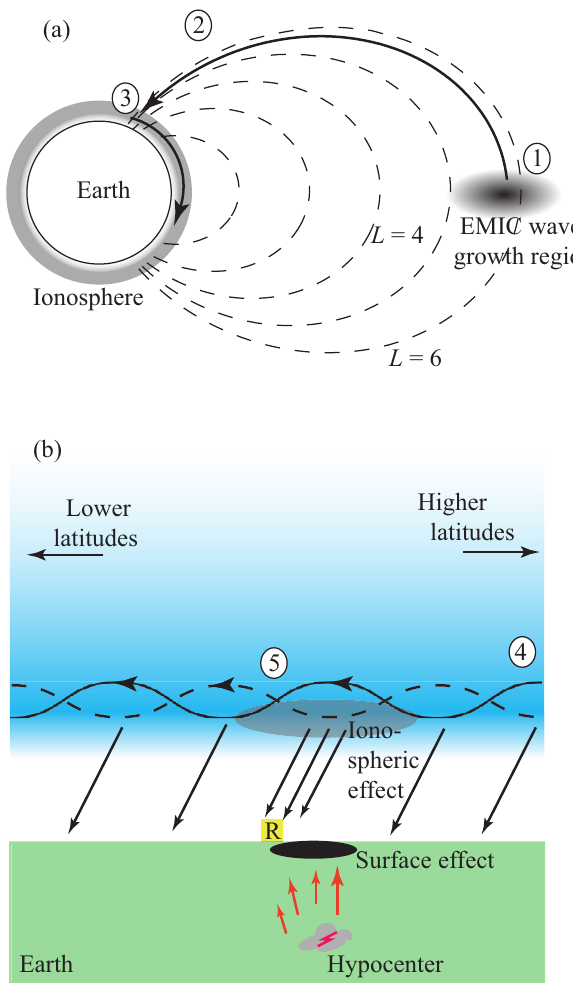
Fig. 2. A possible mechanism of Pc1 modulation by Earthquakes. near the equatorial region in the magnetosphere (1), propagates roughly along the magnetic field line (2), enters the ionosphere at high latitudes (3) and propagates within the dense F-region of the ionosphere to low-latitudes. (b) During its meridional propaga- tion to low-latitudes (4), seismically active regions might affect the ionosphere in such a way as to change the bottomside transmission coefficient (5), resulting in anomalous Pc1 activity recorded at the receiver station